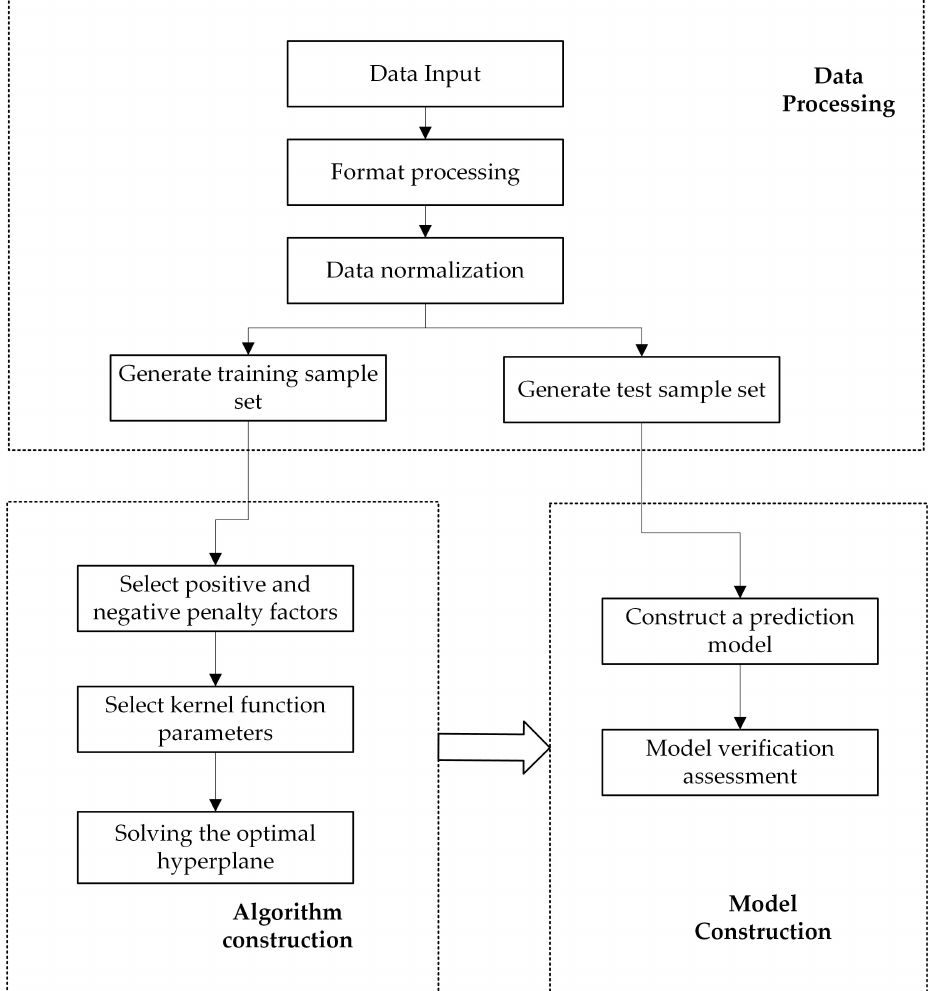
Figure 3. SVM-CSDPC disease prediction model